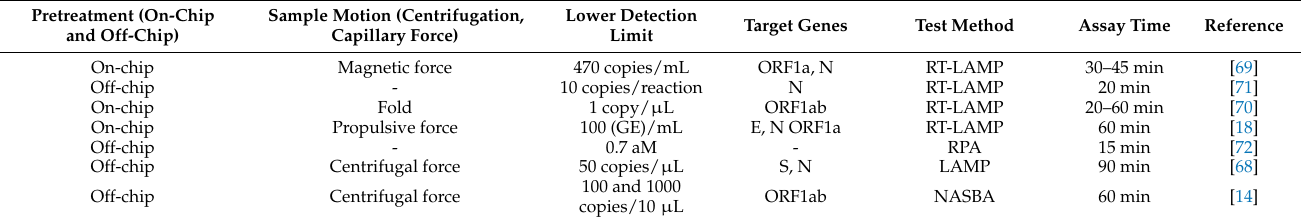
Table 5. The characteristics and data of on-chip isothermal amplification technology are summarized and compared.